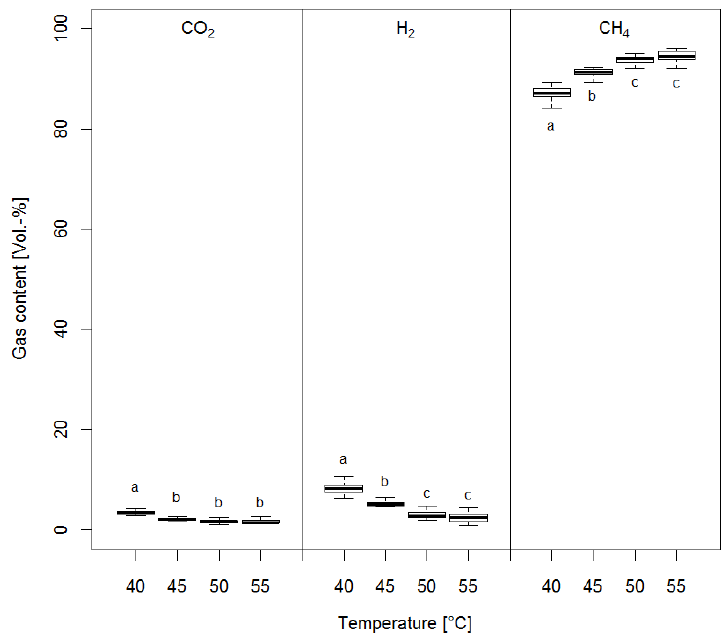
Figure 2. Gas quality of the product gas depending on the different temperatures. The significant differences among the temperature levels are marked with different letters ( p < 0.05, Tukey’s test). The GHSV in these tests ranged from 1.80 ± 0.07 h −1 to 1.90 ± 0.09 h −1 . Although the values differ between the temperature levels, the differences were not statistically significant. The same was for the MFR, which was achieved in the range 8.46 ± 0.45–8.85 ± 0.45 m 3 m −3 d −1 . The temperature increase therefore only increased the gas quality. Differences in the amount of gas produced could not be determined and can be traced back to slightly different amounts of injected gas between the experiments. Another reason for this could be the reduction in the volume by a factor of 5 during the biological methanation process, which was also observed and described in [4].